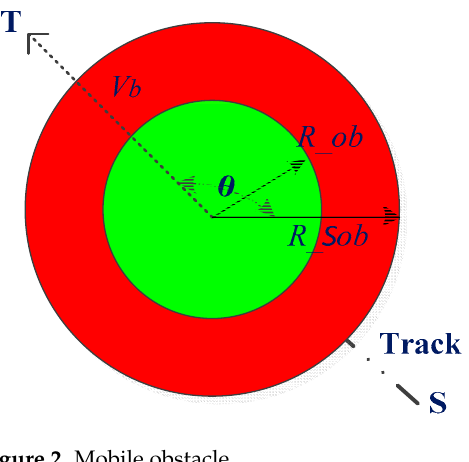
Figure 2. Mobile obstacle.